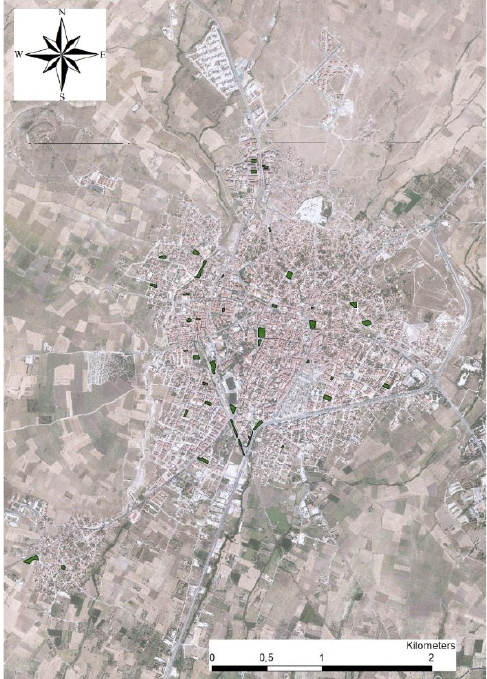
Figure 7. Urban parks in Kırklareli city center